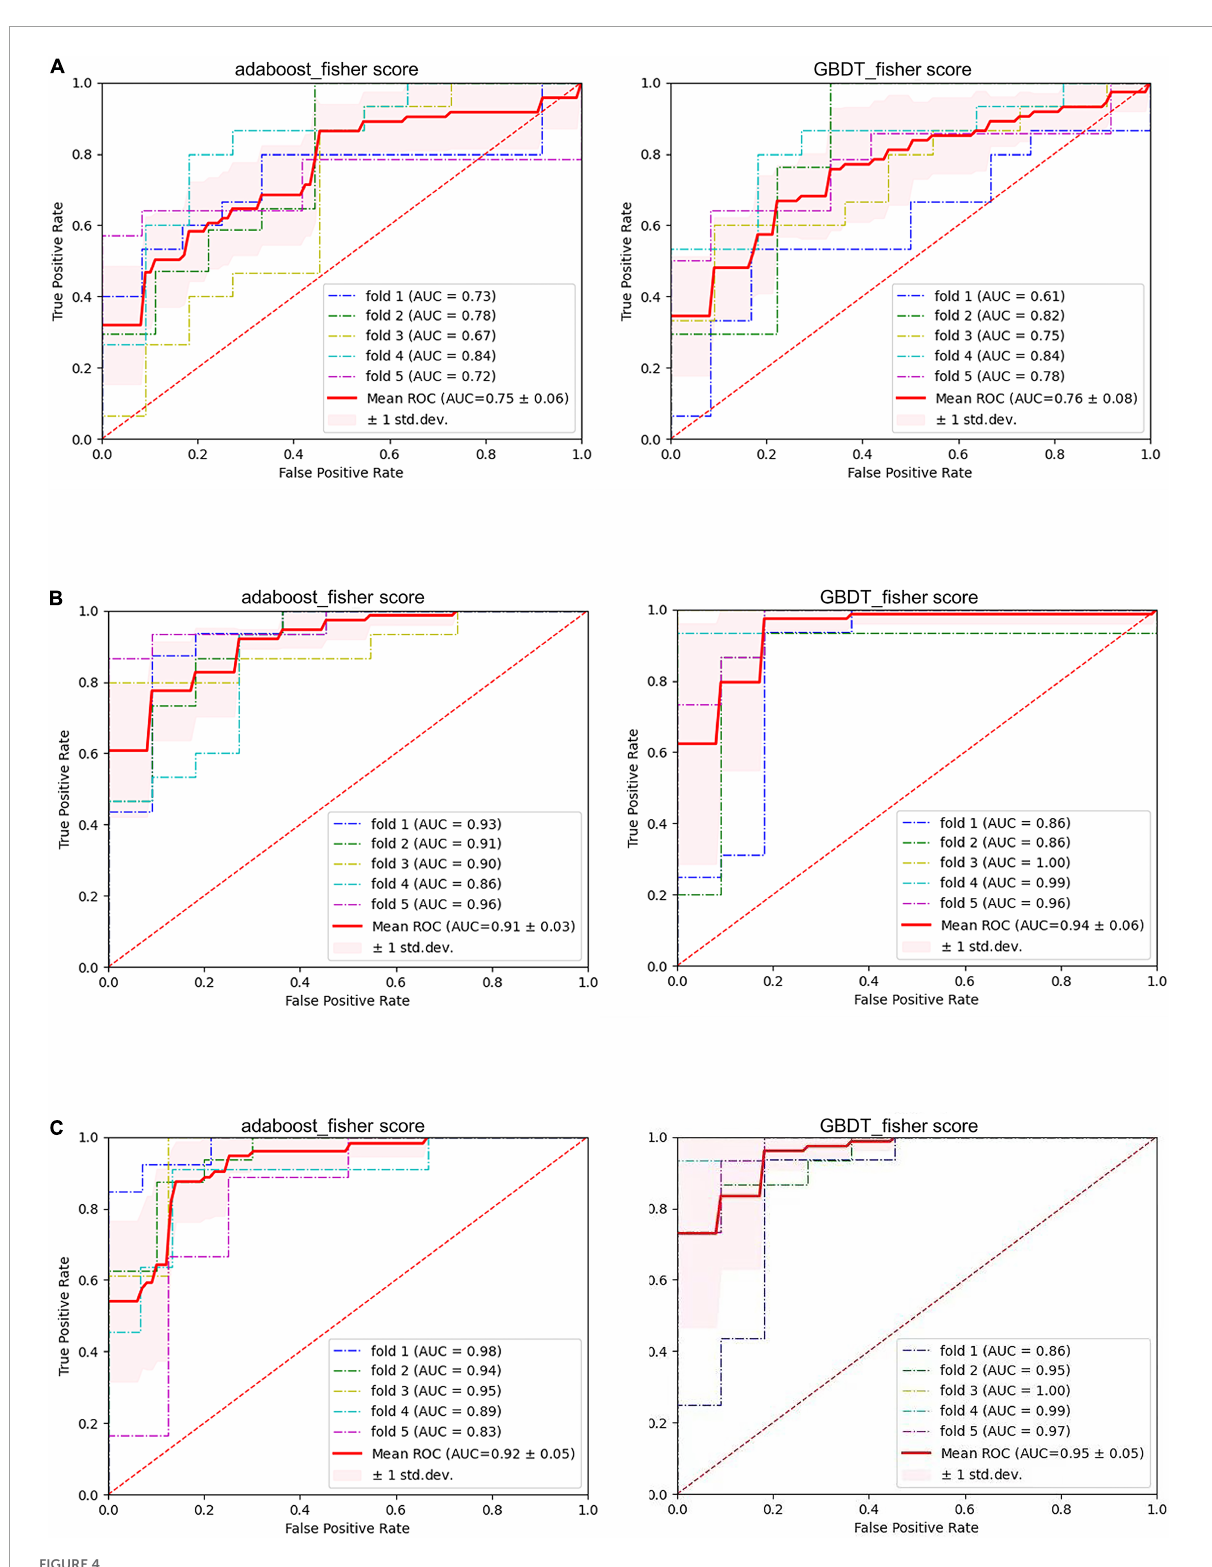
FIGURE4 The performance of six models. (A) Pure clinical features. (B) Pure electroencephalogram (EEG) features. (C) Combined clinical and PLV EEG features. GBDT, Gradient Boosting Decision Tree; AdaBoost, Adaptive Boosting; AUC, area under the curve; ROC, receiver operating-characteristic curve; std. dev, standard